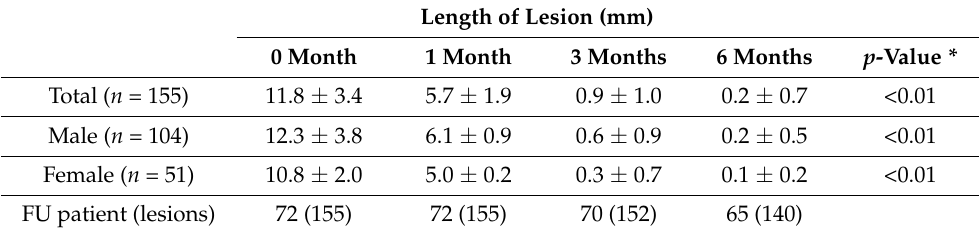
Table 2. Change in the size of the lesion after CO 2 laser treatment.